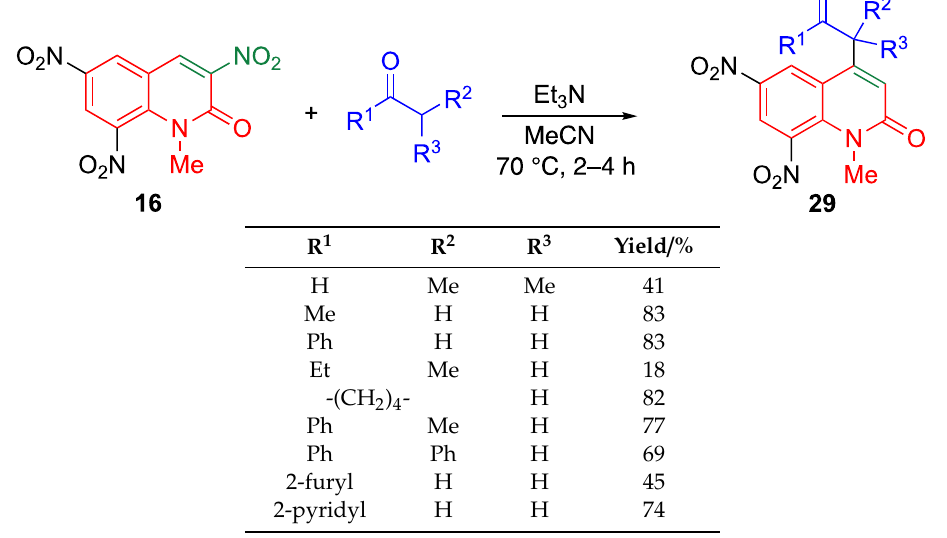
Table 9. cine -Substitution of 16 with ketones.